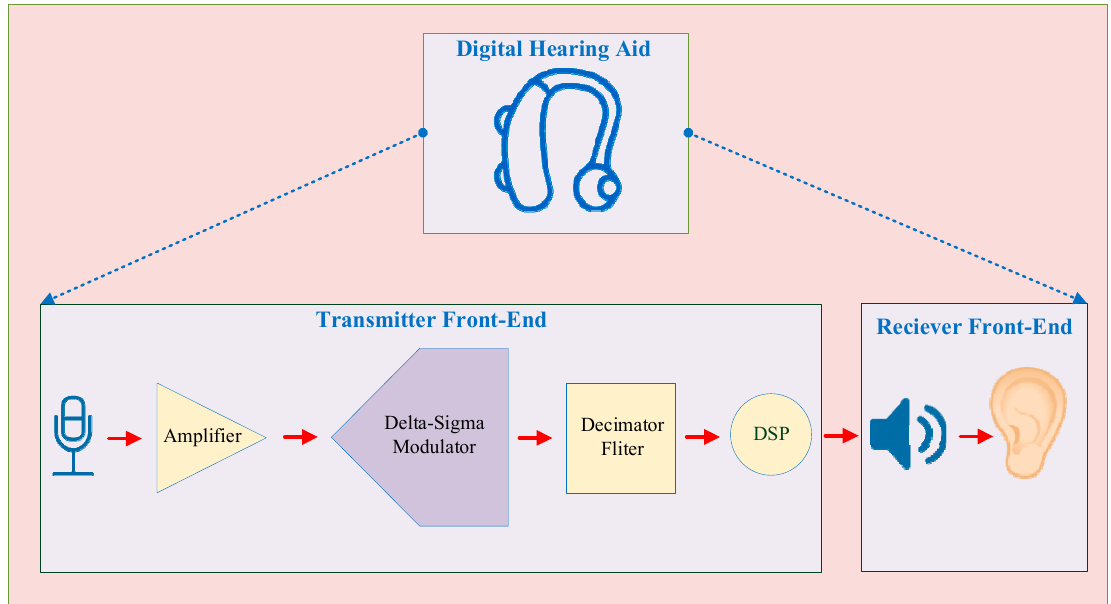
Figure 1. Block diagram of digital hearing aids.